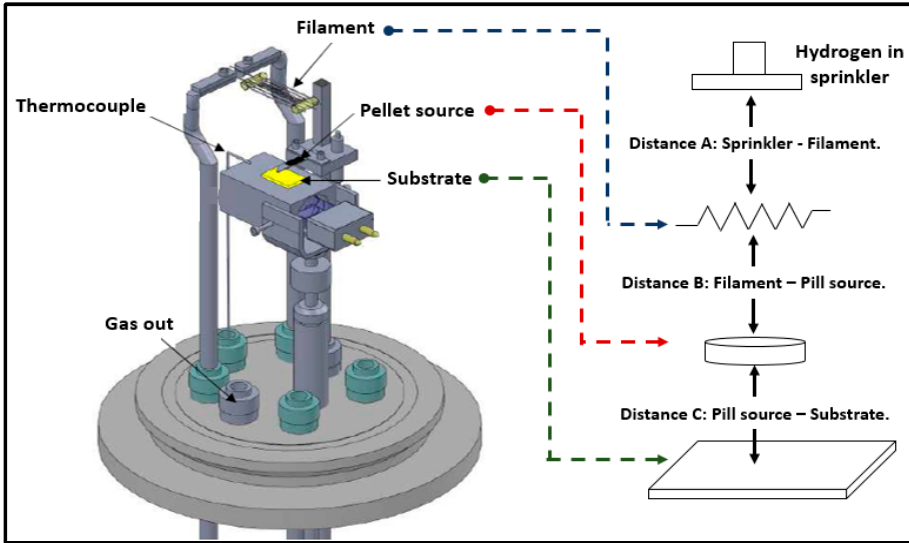
Figure 2. The principal components inside of the reaction chamber.